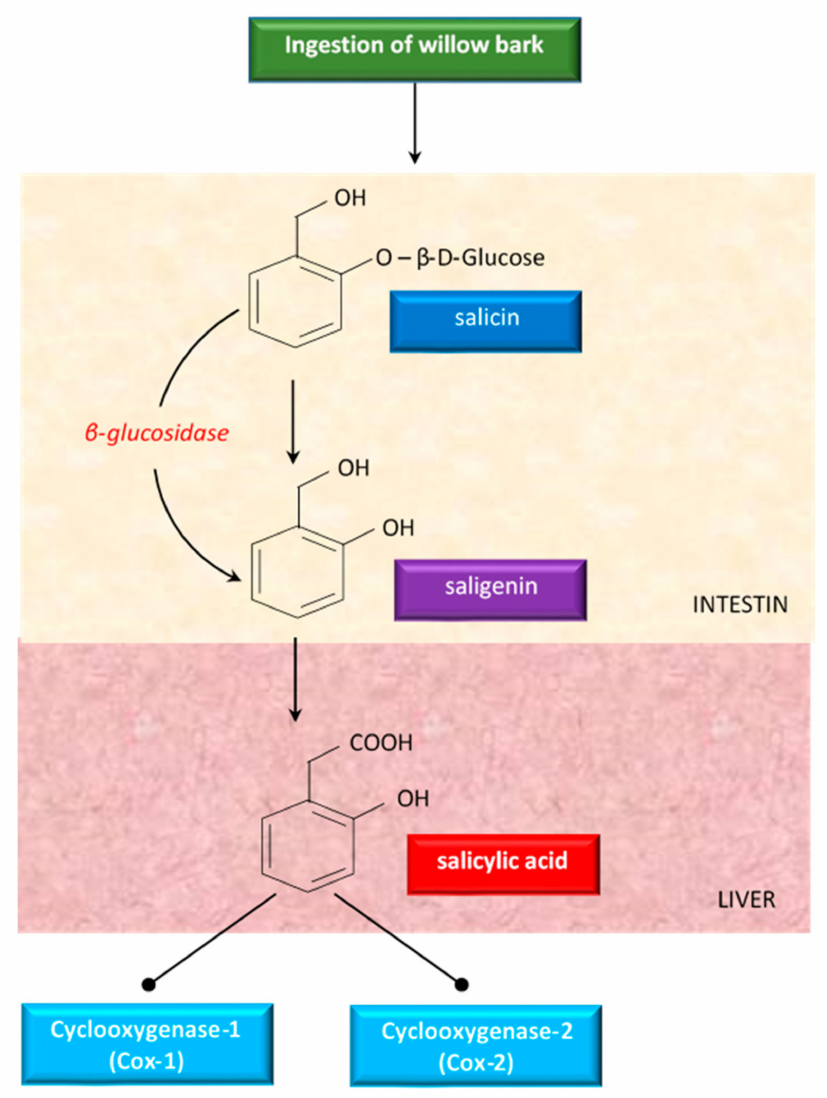
Figure 4. An overview of the metabolism of salicin derivatives from willow